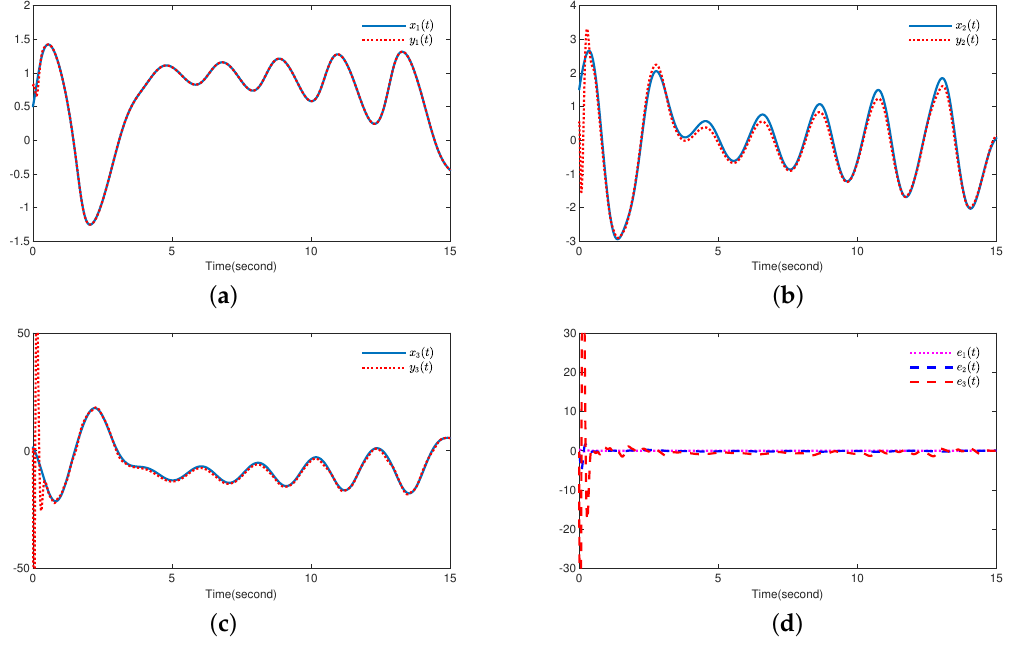
Figure 1. Synchronization performance: ( a ) synchronization performance among x 1 and y 1 ; ( b ) synchronization performance among x 2 and y 2 ; ( c ) synchronization performance among x 3 and y 3 ; ( d ) synchronization